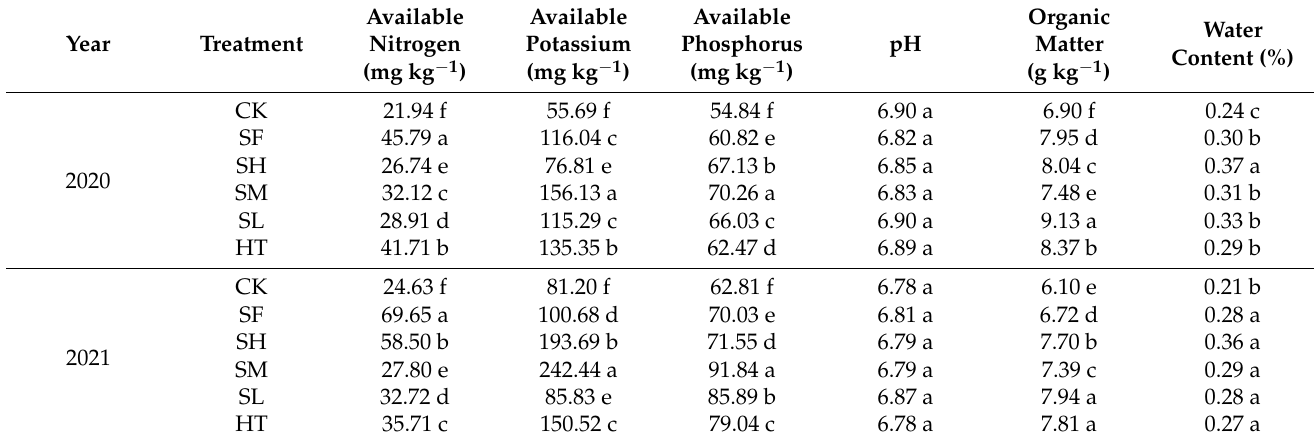
Table 4. Effect of rice straw combined with inorganic fertilizer on soil available nutrient.